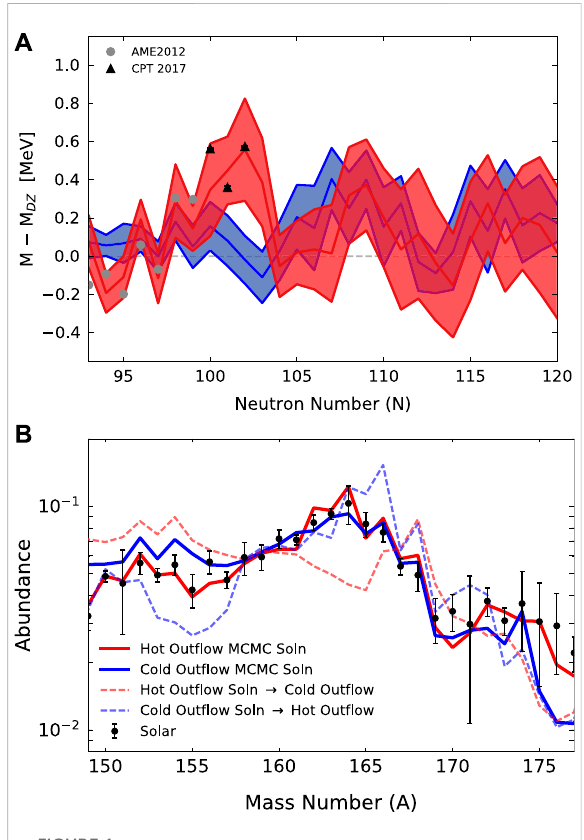
FIGURE 1 (A) The MCMC predicted masses for samarium ( Z =62), relative to the DZ mass model, given two distinct moderately neutron-rich ( Y e =0.2) astrophysical out fl ows that could be found in accretion disk winds: a hot case which undergoes an extended (n, γ ) % ( γ ,n) equilibrium (red band) and a cold case (blue band) for which photodissociation falls out of equilibrium early (adapted from Figure 20 of [15]). The AME2012 data [22] used to guide the calculation is shown along with CPT at CARIBU [14] data of which the calculation was not informed. All bands were determinedfromtheaverageandstandarddeviationof50parallel, independent MCMC runs (B) Demonstration that the mass solutionsareuniquelytiedtotheastrophysicalconditions,withthe solid red line showing the abundance results using the MCMC masses of top panel and the dotted red line showing the results when these masses are applied in a nucleosynthesis calculation with the cold trajectory. Likewise the blue solid line shows the abundancespredictedbythebluebandinthetoppanelalongwith the resultant abundances when this mass solution is applied to the hot trajectory (Figure 2 of [16]). Note that results in the top panel were determined from runs which applied symmetrized Solar data derivedfrom Arnould+07[29](describedin[15])which isshownas black points in the bottom